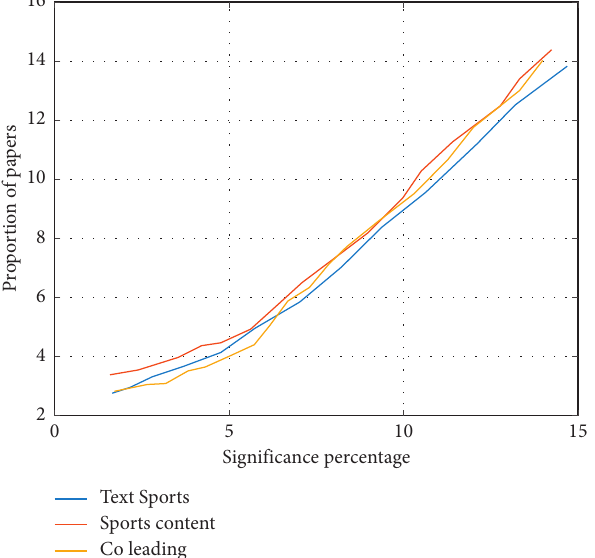
Figure 12: Trend of the percentage of popular research theme groups by dominant type with threshold value.